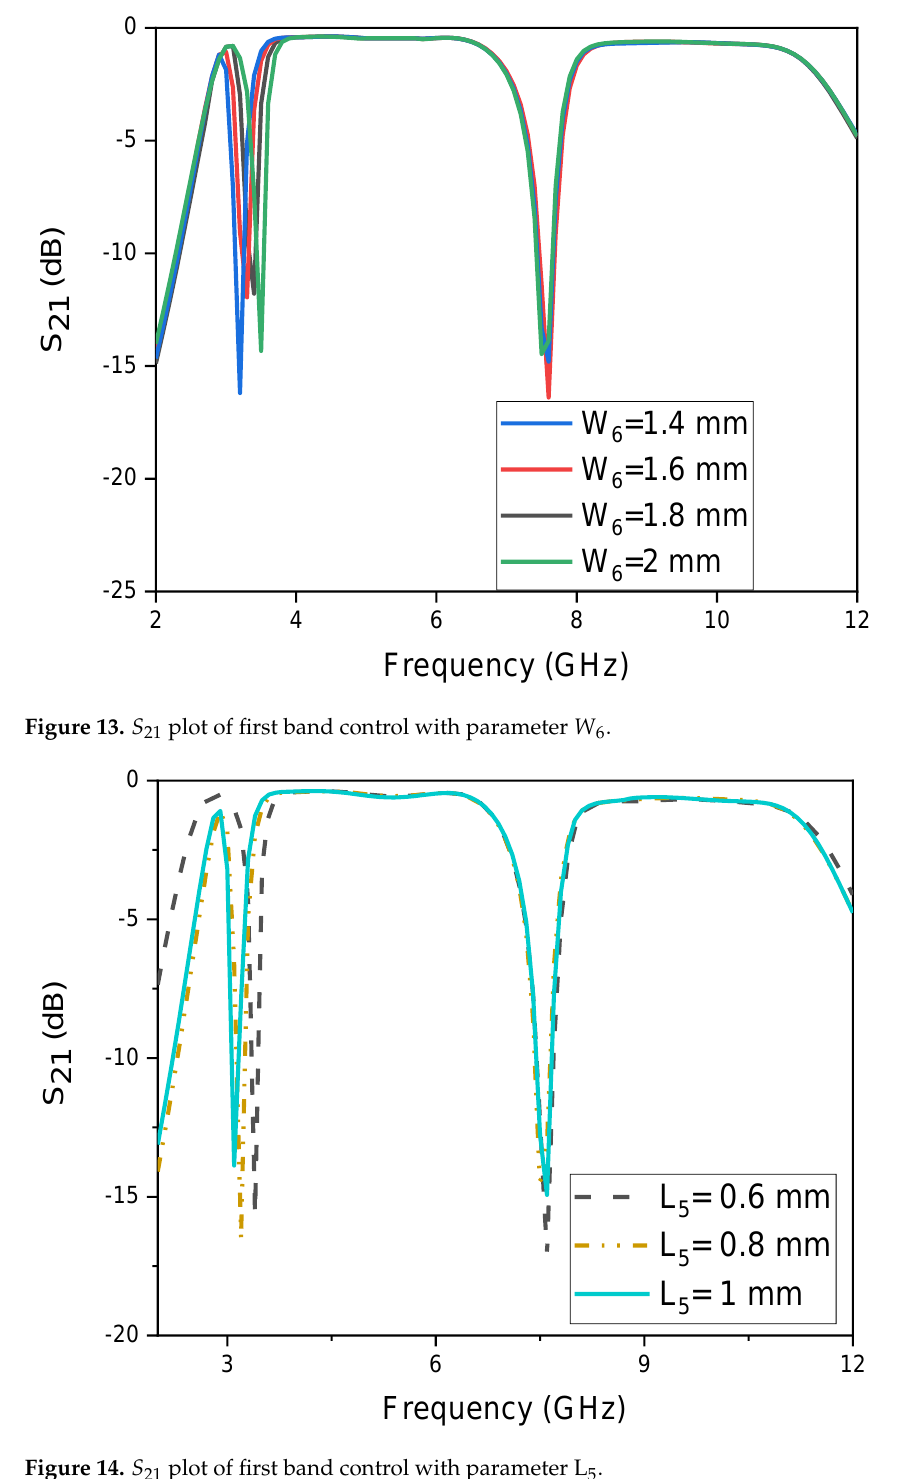
Figure 14. S 21 plot of first band control with parameter L 5 . The second notch band at 7.5 GHz is mainly controlled with the parameters L 3 and W 3 , i.e., by small changes in the length L 3 from 3.8 mm to 4.1 mm, a large variation can be seen, as shown in Figure 15, while the first stopband was constant. Similarly, when the width W 3 increased from 0.1 mm to 0.4 mm, a reasonable change occurred in the second band, while keeping the first stopband constant, as given in Figure